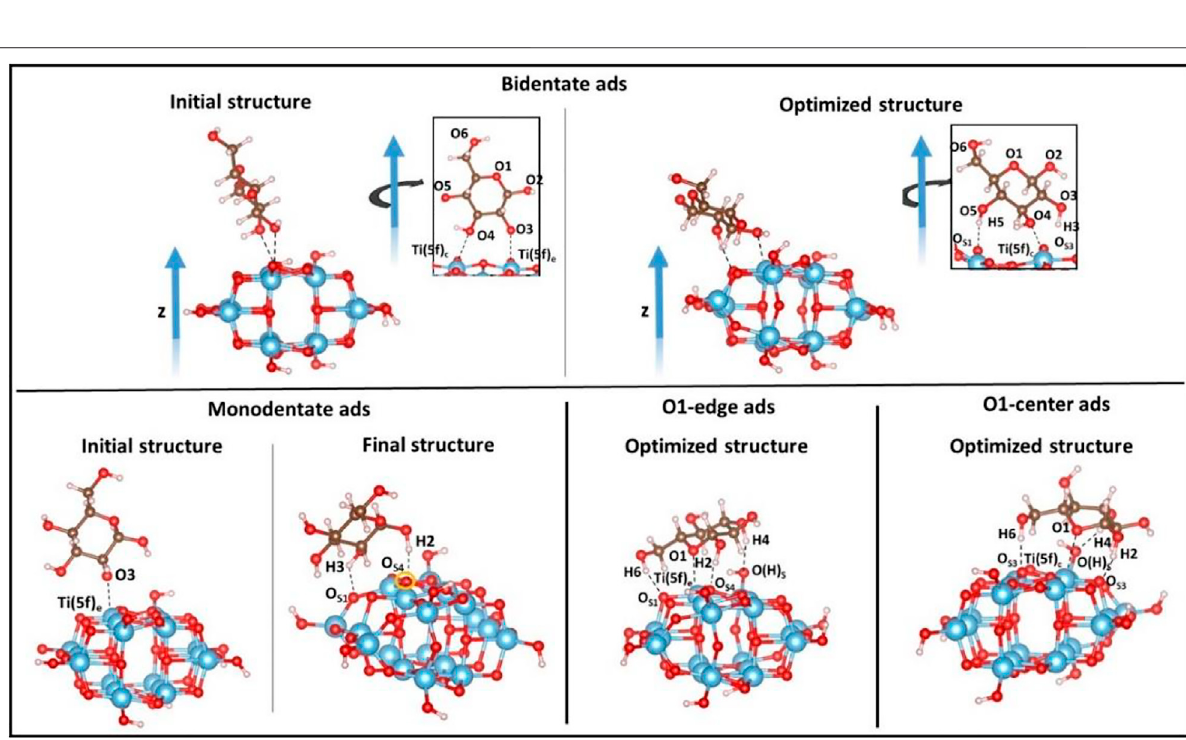
Frontiers in Chemistry |